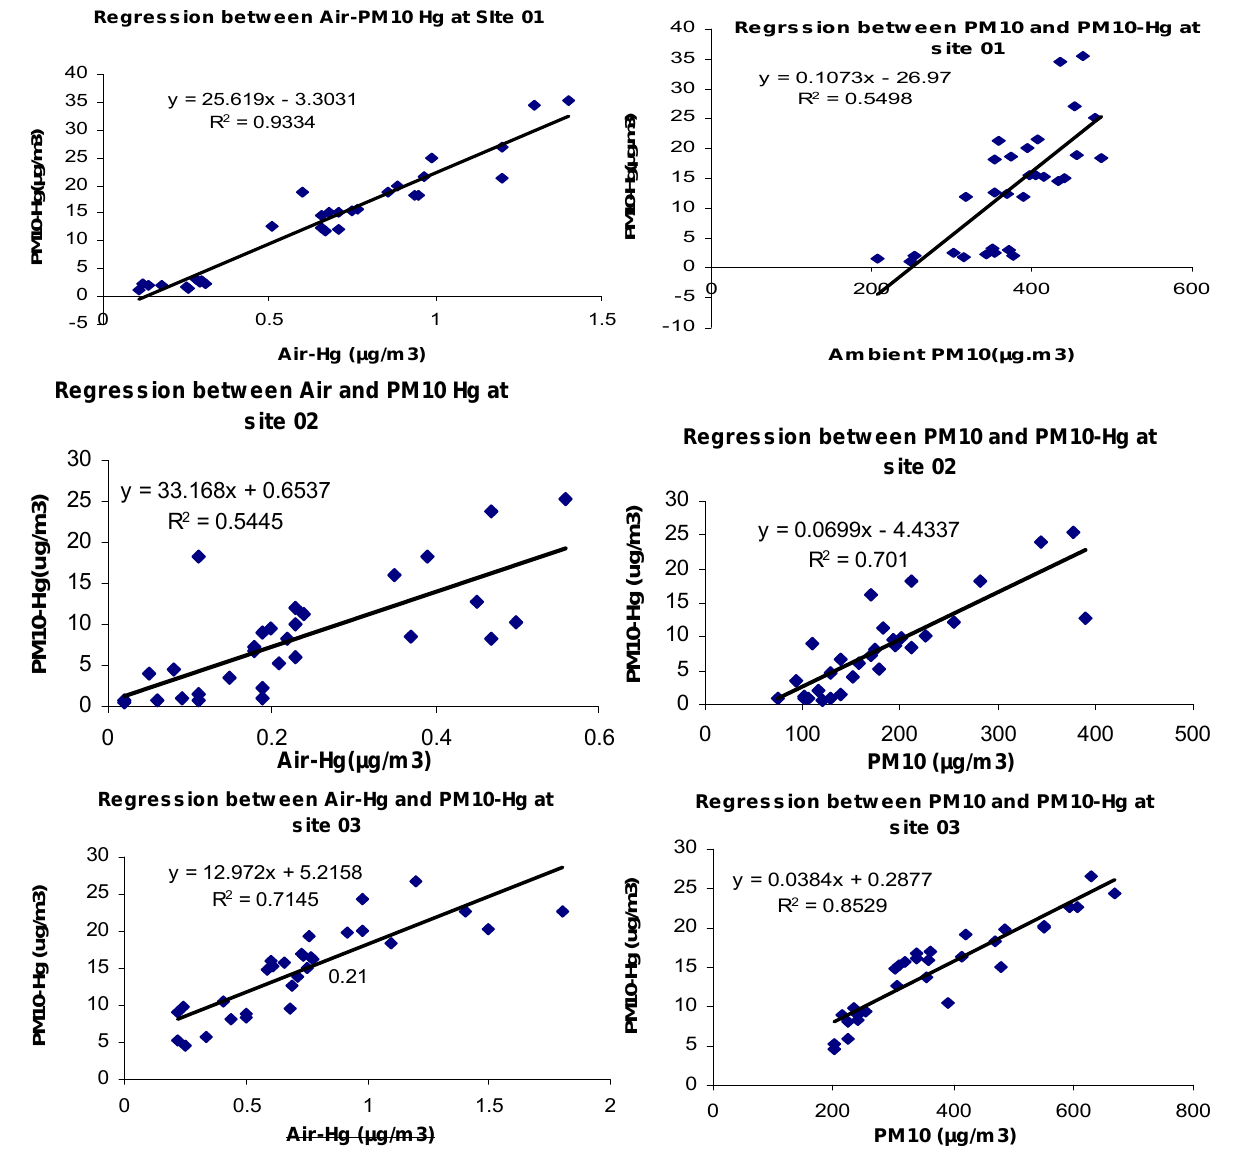
Fig. 4. Regression graph of selected measurements of PM 10 , PM 10 -Hg and Air-Hg at identified sites around steel plant,